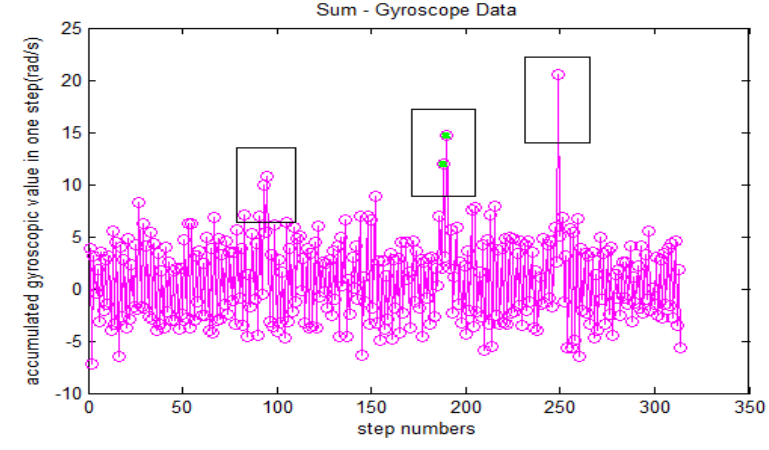
Figure 4. Analysis on the accumulated gyro value.